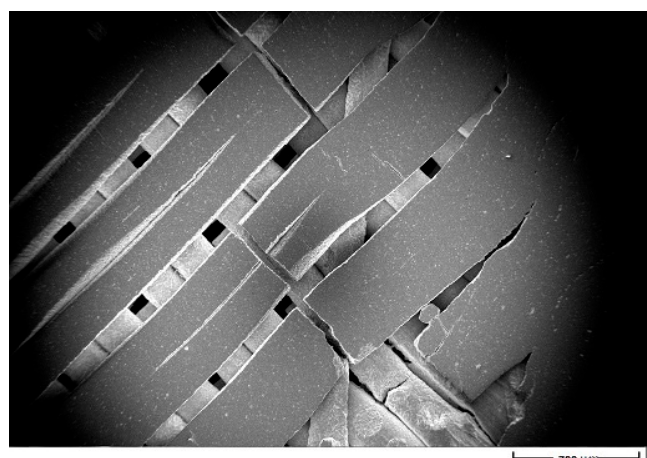
Figure 6. Low magnification SEM image of a dense sample illustrating open spaces between filaments.